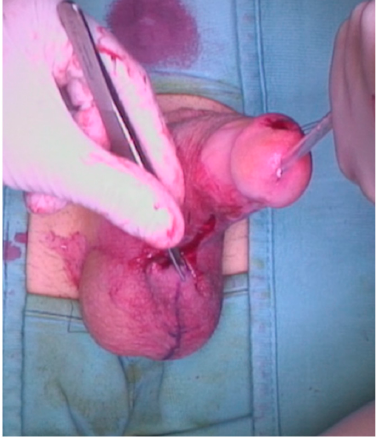
Figure 6. The scrotal access.